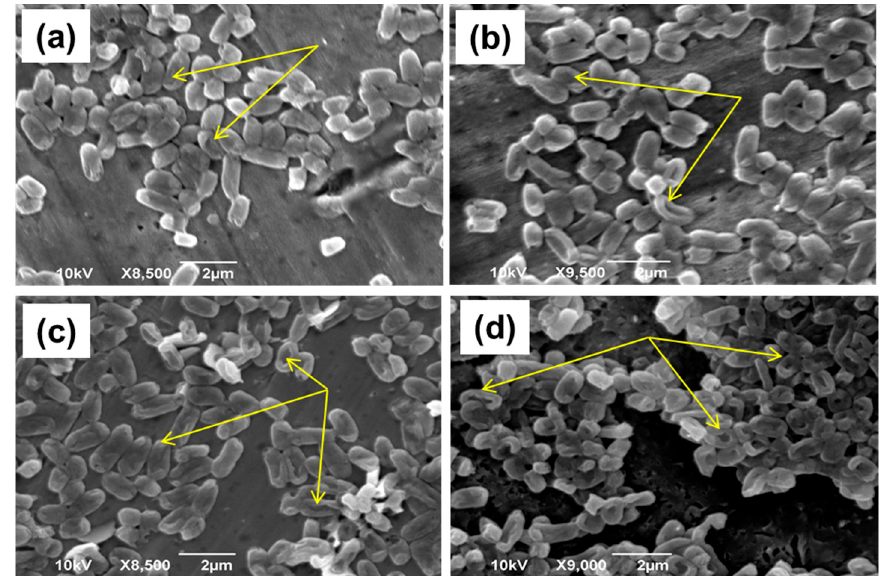
Figure 8. SEM images of E. coli MG1655 bacteria ( a , b ) exposed to the photocatalyst in the dark for 1.5 and 3 h, respectively, and ( c , d ) exposed to the photocatalyst under light irradiation for 1.5 and 3 h, respectively. The arrows indicate some of the most visible damaged cells.